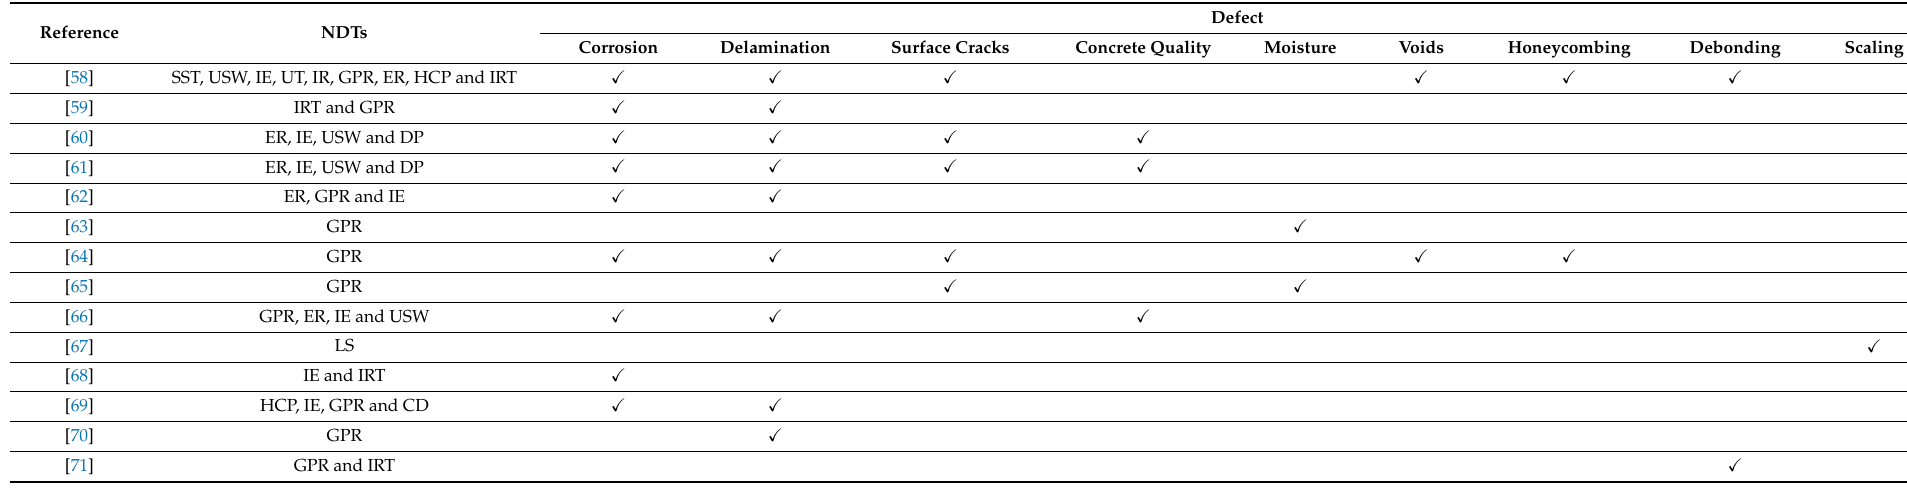
Table 8. Description of some of the studies in the research domain of CBD_NDT.